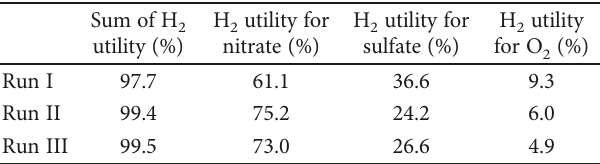
H utility for 2 sulfate (%)